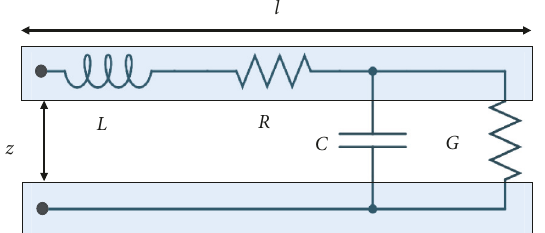
Figure 2: Geometrical diagram of the two parallel plates with the equivalent circuit.